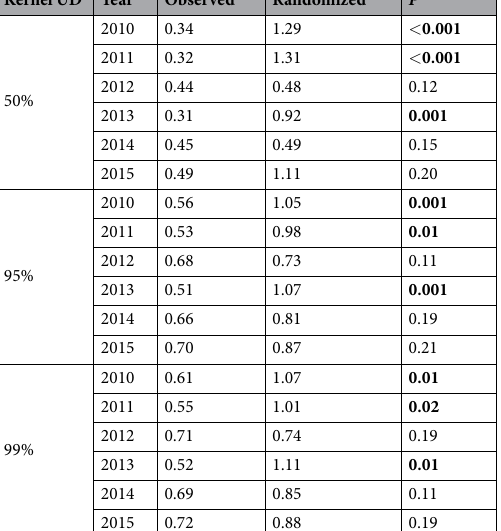
Methods Fieldwork. Seventy-three Cory’s shearwaters (N = 34 females and N = 39 males) were tracked during several foraging trips (N = 139 female and N = 210 male) with GPS-loggers (IgotU GT-120; Mobile Action Technology Inc., Taiwan) on Berlenga Island located in the Portuguese coast (39°23 ′ N, 9°36 ′ W), during 15-August – 15 September (mid chick-rearing period) of 2010–2015 (Table 1). The devices weighed 17 g, which represented between 2.2% and 2.9% (median = 2.6%) of the birds’ mass and was below the 3% threshold advised by ref. 39. Devices were set to record locations each 5 minutes. GPS loggers were then attached using TESA ® tape to the con- tour feathers along and in between both scapulas. The whole process took less than 10 minutes, thus minimizing